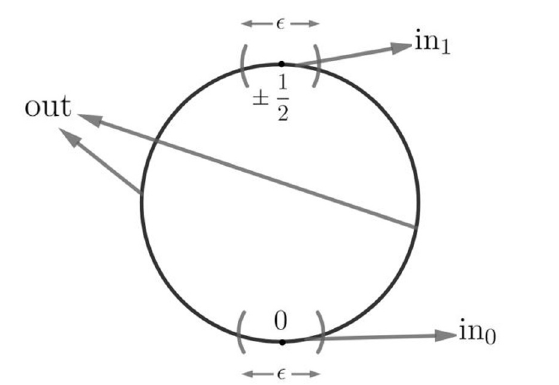
] with − 1 and + 1 identified. For , + 1 2 2 2 2